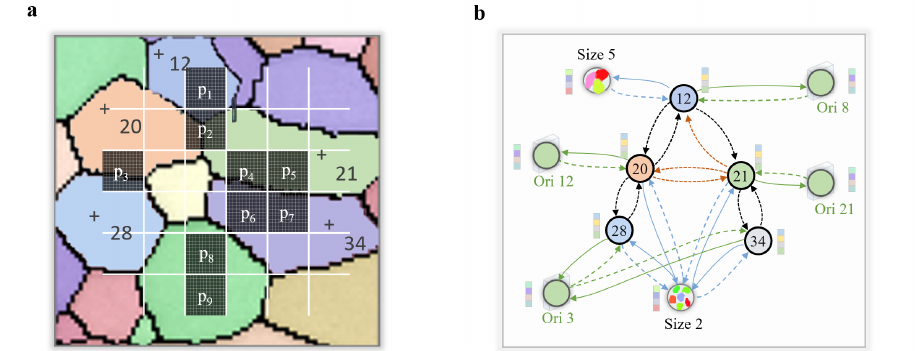
Figure 8. Representation structure comparison. ( a ) The image storage structure. ( b ) The grain knowledge graph storage